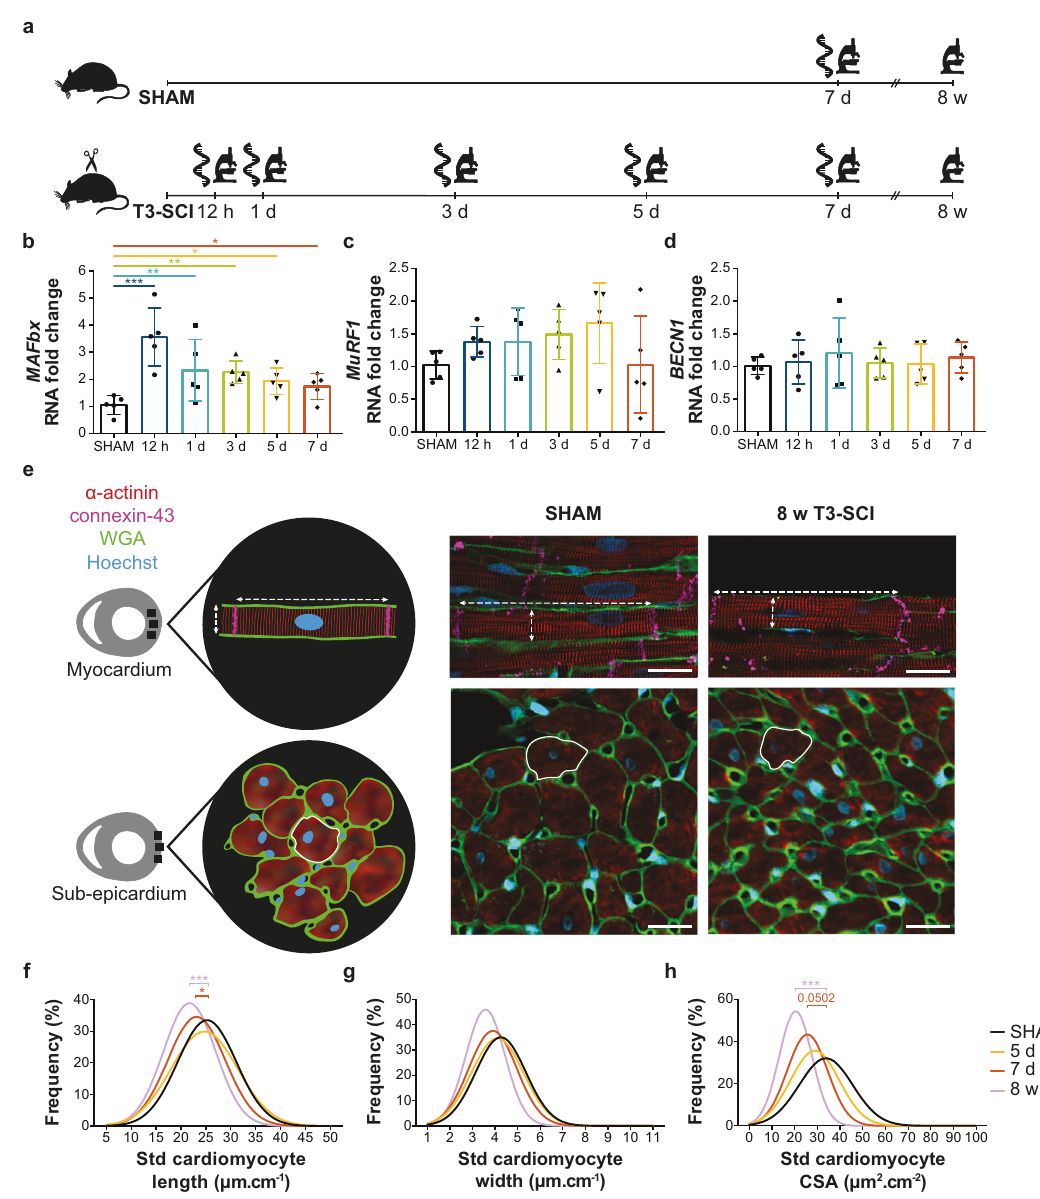
Fig. 5 Temporal progression of changes in gene expression of proteolytic pathways in LV tissue and cardiomyocyte structure from rats with SHAM injury or T3 complete transection SCI (T3-SCI). a Methods timeline (cross-sectional): LV tissue was collected from T3-SCI rats across the acute-to- chronic continuum post SCI to assess proteolytic gene expression (qPCR; 12 h, 1 day, 3 days, 5 days, and 7 days) and cardiomyocyte dimensions (immuno fl uorescence; 1 day, 3 days, 5 days, 7 days, and 8 weeks). SHAM tissue was collected at 7 days post-SHAM. b The RNA fold change of ubiquitin- proteasome system (UPS) marker atrogin-1 ( MAFbx ) was elevated at all acute timepoints post SCI vs. SHAM, while UPS marker c muscle RING- fi nger protein ( MuRF1 ) and d autophagy marker beclin-1 ( BECN1 ) showed no changes in gene expression. Gene expression data are presented as mean ± SD with individual rats represented as symbols ( n = 5/group). e On the left is a schematic representation of where cardiomyocytes were imaged with methods of measurement. On the right, representative immuno fl uorescence images of longitudinally oriented cardiomyocytes located in the myocardium of the LV free wall shown in the top row with length and width represented as dotted white lines (wheat germ agglutinin, WGA). Cross-sectionally oriented cardiomyocytes located in the sub-epicardium of the LV free wall are shown in the bottom row with cross-sectional area (CSA) contoured with a solid white line. Scale, 20 mm. For replication, a minimum of 130 lengths, 210 widths, and 98 CSAs were averaged per animal. f Frequency distributions as Gaussian curves centered at the mean of standardized to femur length (std) cardiomyocyte length, g width ( n = 5 – 9/group), and h CSA ( n = 5 – 9/group) are shown; only the 5 and 7 days T3-SCI groups are represented for the acute timepoints for clarity. Std length was reduced at 7 days and 8 weeks post SCI vs. SHAM (left shifts), while std CSA tended to be reduced at 7 days post SCI and was reduced at 8 weeks post SCI vs. SHAM. Gene expression and cardiomyocyte measures were analyzed using a linear mixed regression model vs. SHAM with coef fi cient (group mean differences) t -test p -values: * p < 0.05, ** p < 0.01, and *** p < 0.001. See Supplementary Table 3 for all histological and molecular outcomes. Source data are provided for all variables shown in this fi gure in the source data fi